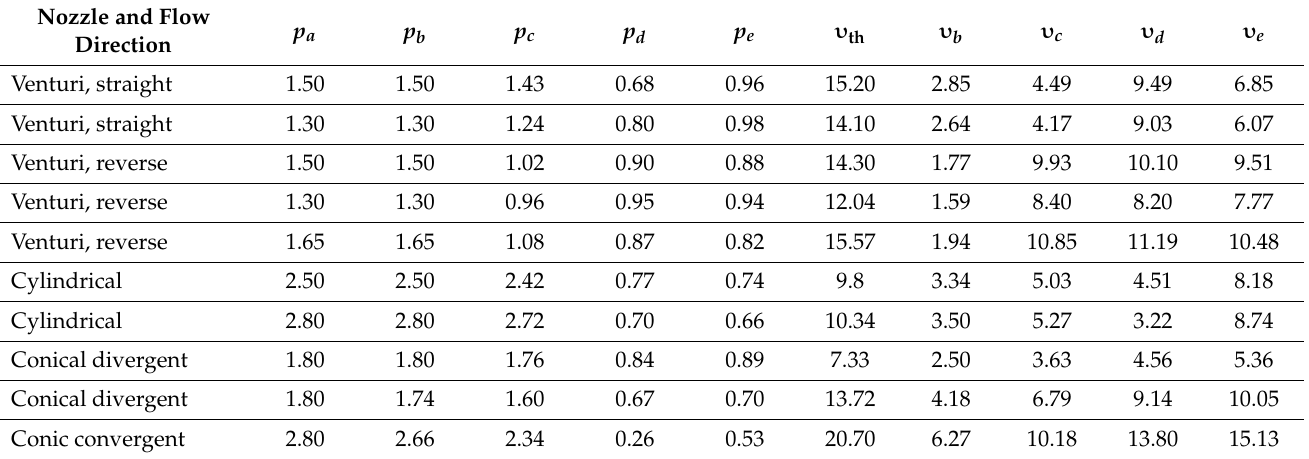
Table 1. Absolute pressure and velocity (in atm. and m/s) (from our CFD results).